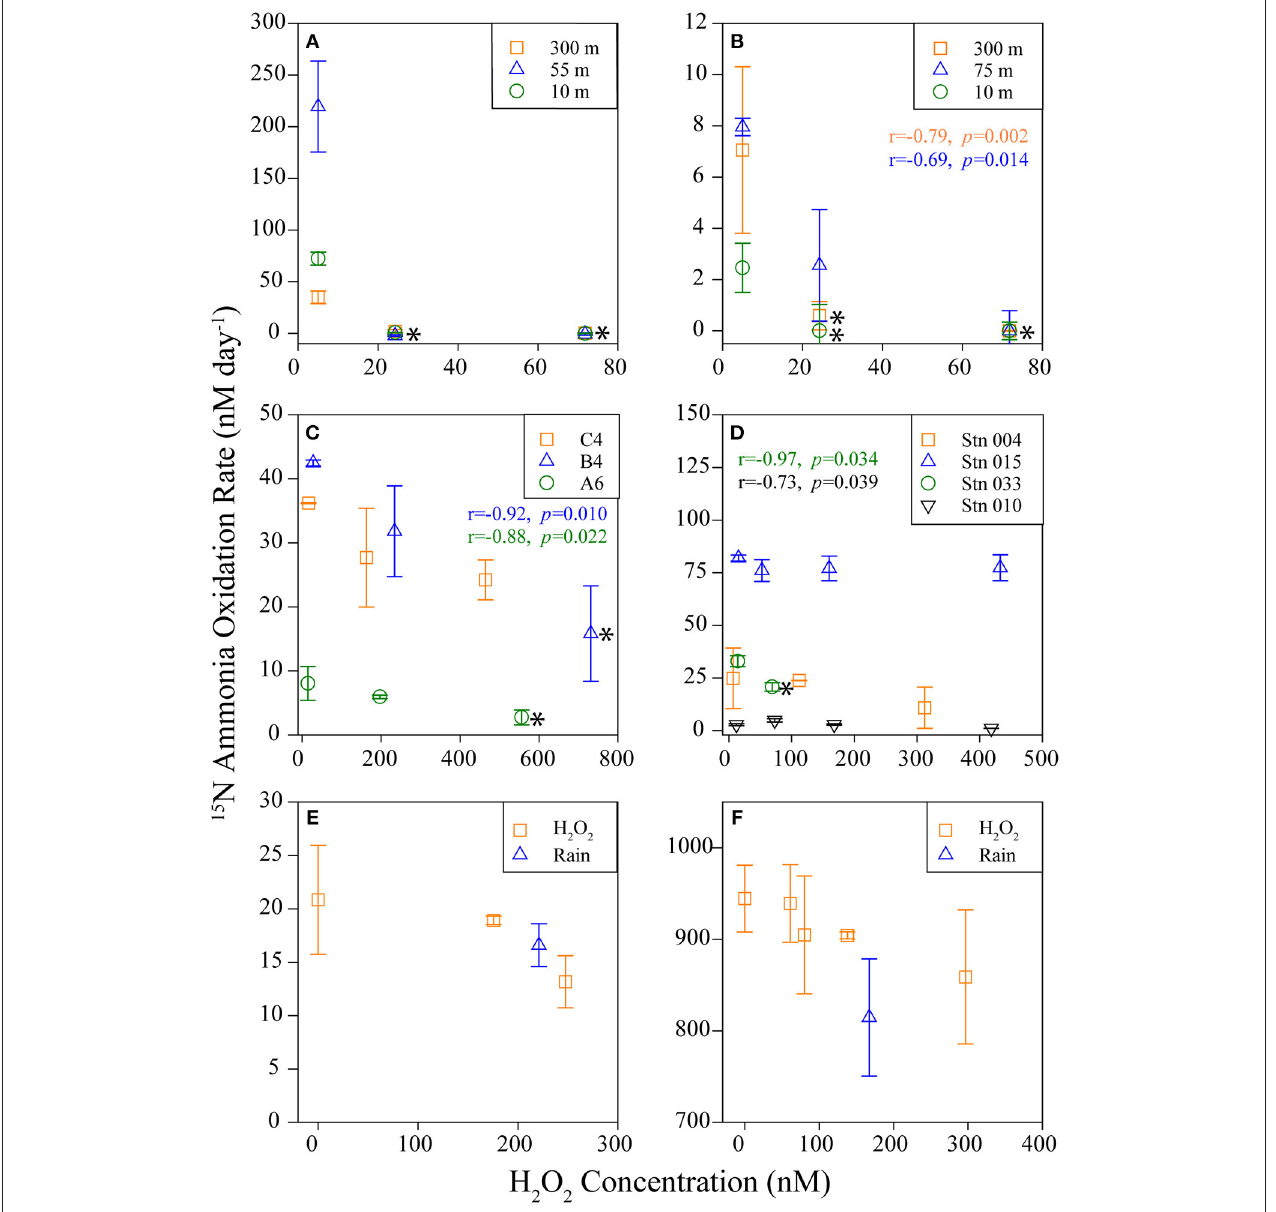
FIGURE 4 | 15 N-Ammonia oxidation rates. AO rates measured following H 2 O 2 amendments of samples from the Southern Ocean ( A Station 600.160, B Station 600.080; symbols represent sample depth), Gulf of Mexico and Gulf of Alaska ( C,D , respectively; symbols represent stations sampled; sample depth was 200m except at Station 015, which was sampled at 50 m), and coastal waters from Marsh Landing in (E) 2012 and (F) 2013 (symbols represent H 2 O 2 origin, either chemical H 2 O 2 or from rainwater; surface water samples collected). Error bars represent standard deviation from the mean of replicate AO measurements [ n = 4 (A,B) , 2 (C–F) ]. An * to the right of a point indicates a significant difference ( t -test, p < 0.05) from the control rate (for A,B , overlapping points were all significantly different, and are represented by only one *). H 2 O 2 concentrations measured for each individual sample; non-control sample [H 2 O 2 ] includes added H 2 O 2 . Pearson’s correlation coefficient (r) and associated p- value are shown for those samples with a significant regression between rate and [H 2 O 2 ], color-coded to match legend for each panel (note that regressions were not done for Station 600.160 (A) as [H 2 O 2 ] was not